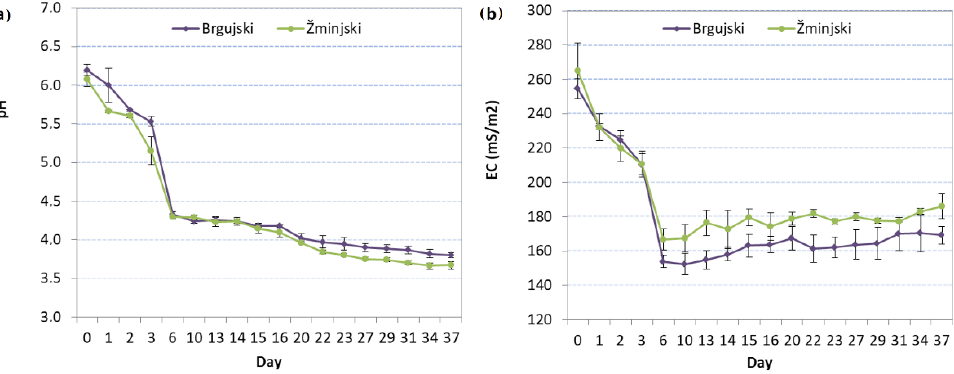
Figure 1. Changes in ( a ) pH and ( b ) EC (mS/m) of cabbage ‘Brgujski’ and ‘Žminjski’ during fermen- tation.